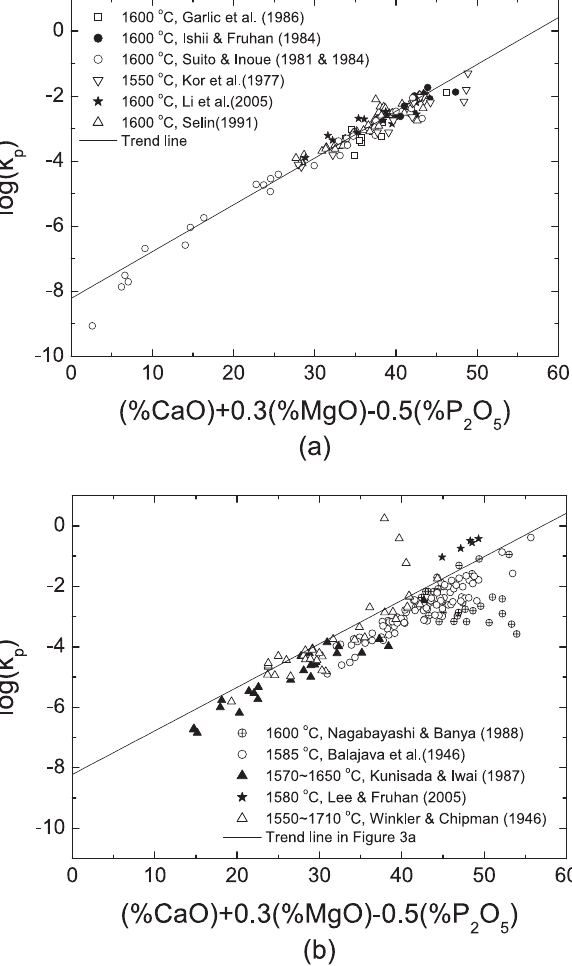
O -FeOn system. Fig. 3: Comparison of the literature data on the relationship between 2 5 log(k ) and slag chemistry [13–21, 22–24, 27, 33, p